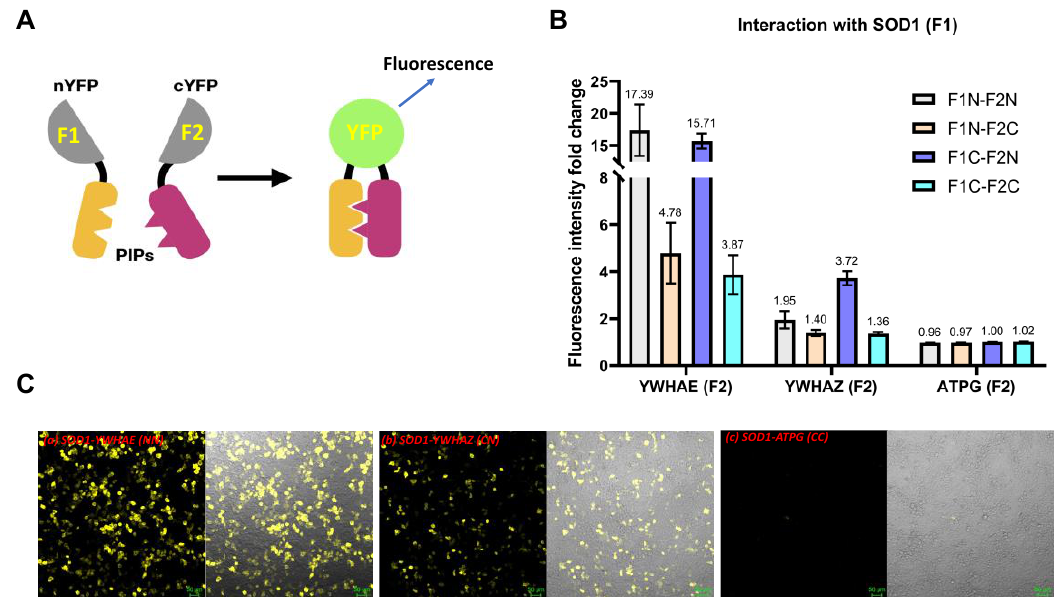
Figure 1. Evidence for protein – protein interactions between human SOD1 and YWHAZ or YWHAE by protein complementation assay (PCA). ( A ) A scheme of the PCA principle. SOD1 was tagged with F1, and YWHAZ, YWHAZ, and ATPG were tagged with F2. ( B ) Relative binding intensity between SOD1 and YWHAZ, YWHAE, or ATPG at different orientations. The fold change of fluorescent intensity was normalized to the control vector pair in the same orientation as a background control. ( C ) Representative images of fluorescent microscopy of transiently transfected HEK293T cells expressing the target protein pairs: ( a ) SOD1-YWHAE in F1N-F2N, ( b ) SOD1-YWHAZ in F1C- F2N, ( c ) SOD1-ATPG in F1C- F2C. Scale bar, 50 μm. The left pane l is a fluorescence image, and the right panel is the fluorescence overlapping with its brightfield image. The image was representative of three sets of data.